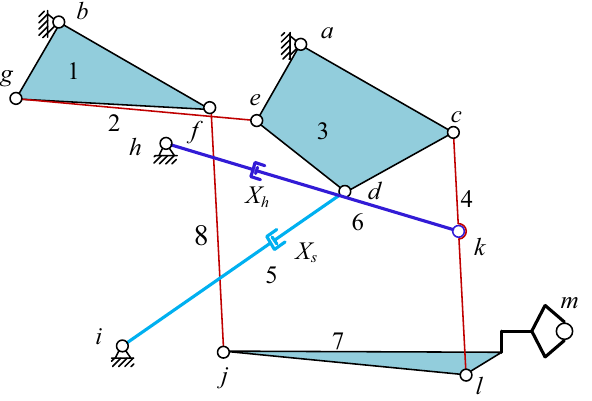
Figure 3. Kinematic sketch of suspension system of the DFMS.